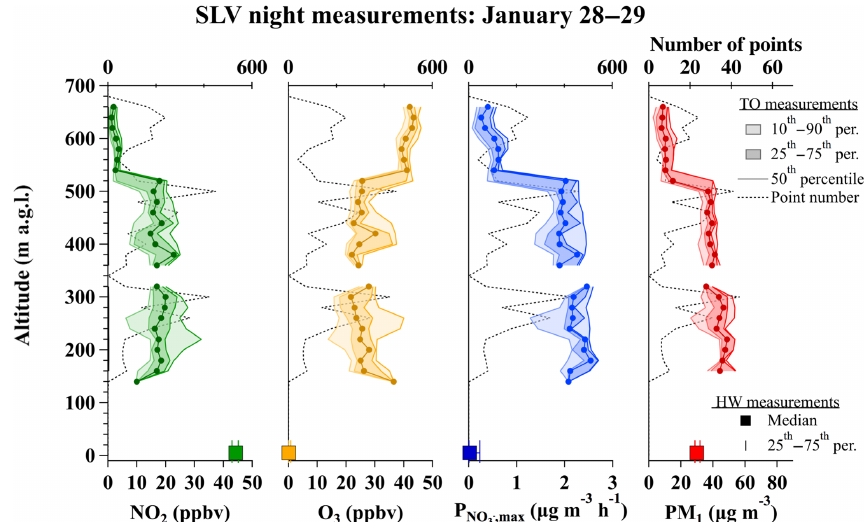
Figure 7. Vertical profiles of NO 2 , O 3 , P (1s data), and PM 1 (10s data) measured from the TO aircraft during five box patterns, NO − 3 , max flown over the SLV urban core between 21:20 and 00:30MST on 28 and 29 January. Percentiles and number of points at each altitude are shown as in Fig. 6. Square markers and error bars represent the median and 25th–75th percentile range of NO 2 , O 3 , P measured concurrently at the HW ground